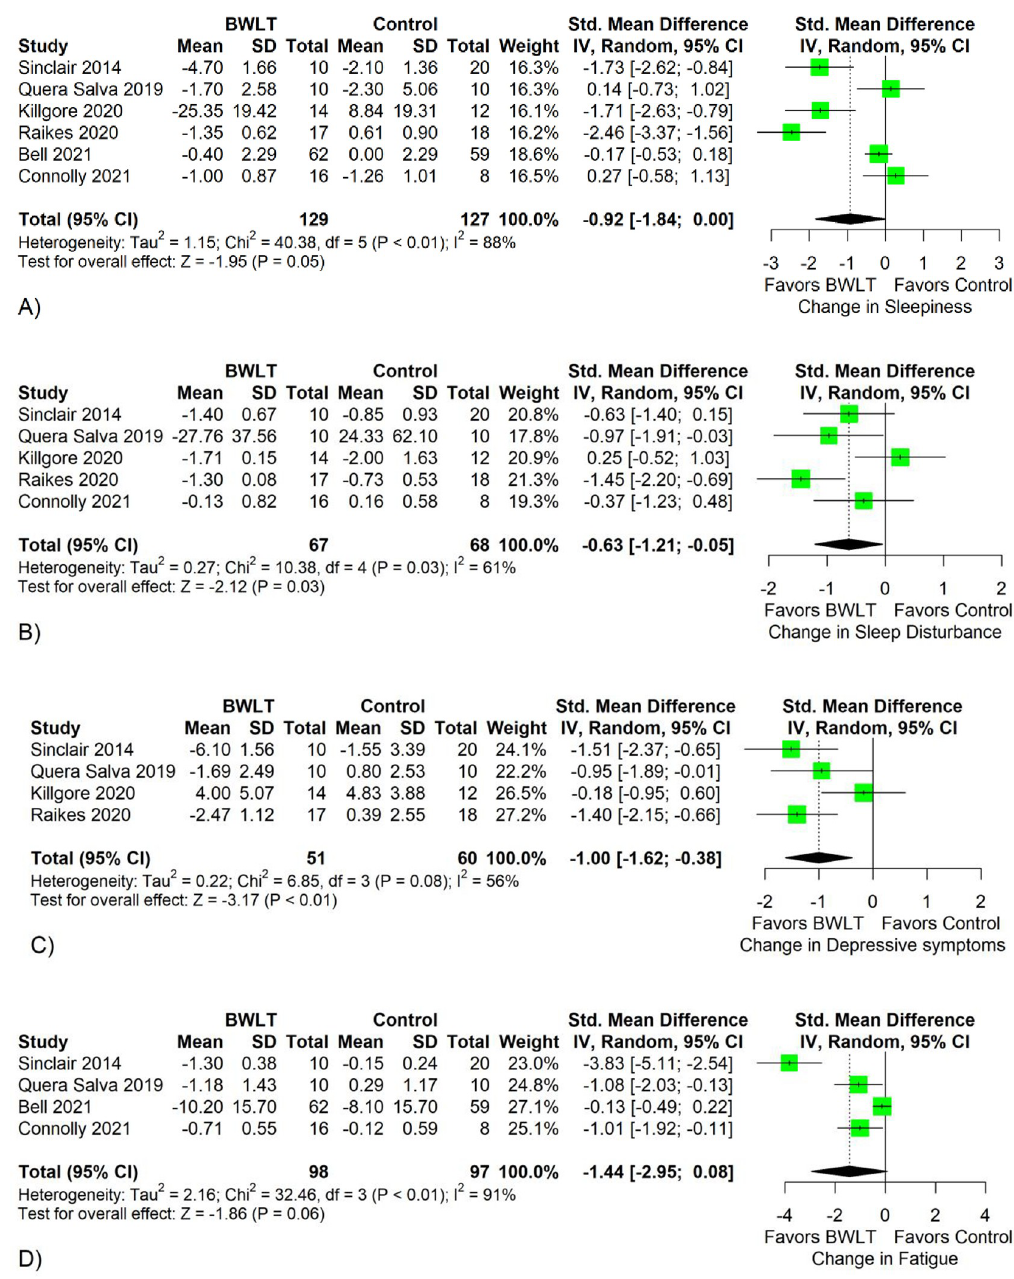
Fig 3. Forest plots comparing the efficacy between blue-wavelength light therapy (BWLT) and control interventions in reducing behavioral symptoms. Behavioral symptoms included sleepiness (A), sleep disturbance (B), depressive symptoms (C), and fatigue (D). Standardized mean differences (SMDs) expressed the differences in depressive symptom reduction between groups. The diamonds indicate the treatment estimates of the total sample. Control interventions included amber, red, or no light